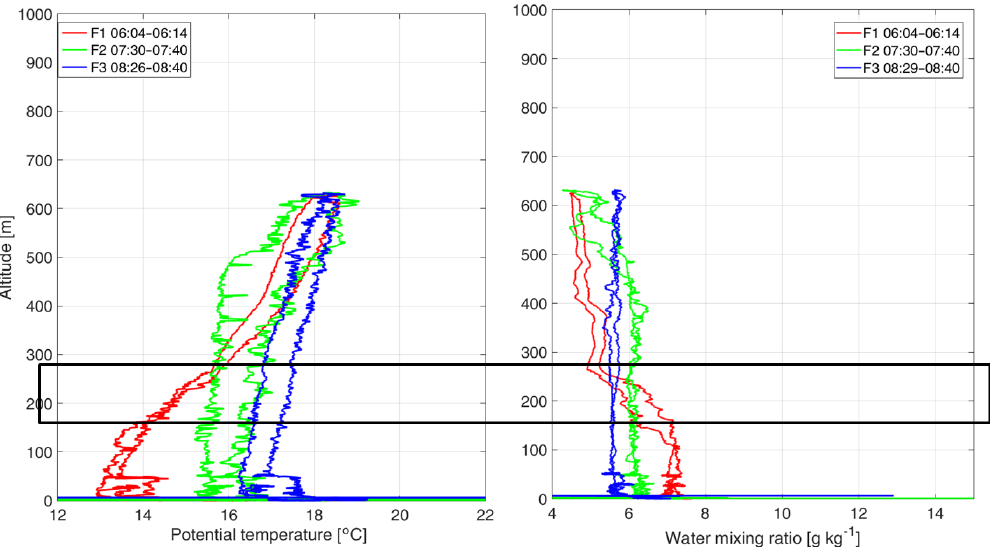
Figure 7. Profiles of potential temperature and water vapour mixing ratio obtained on 23 May 2018. The times of the five flights are given in UTC. The horizontal box represents the height interval of the temperature inversion, which is also visible in the large changes of the water vapour mixing